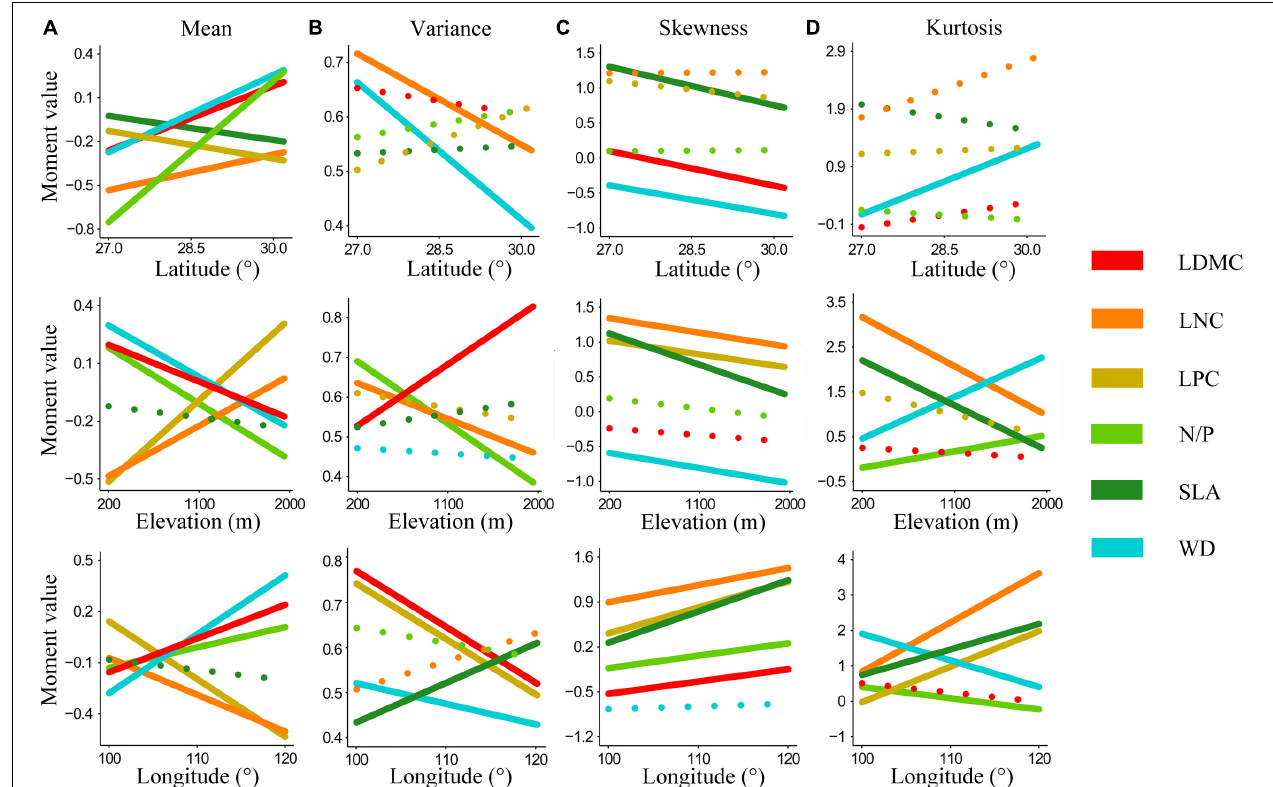
FIGURE 1 | Shifts in the community-weighted moments of six key plant functional traits along geographical gradients. (A–D) Abundance-weighted moments of whole-community functional trait distribution across latitude, elevation, and longitude. Lines represent linear regressions on trait moment values and geographical gradients. Solid lines signify significant regressions. Functional traits are abbreviated as follows: leaf dry matter content (LDMC), leaf nitrogen concentration (LNC), leaf phosphorus concentration (LPC), leaf nitrogen/phosphorus ratio (N/P), specific leaf area (SLA), wood density